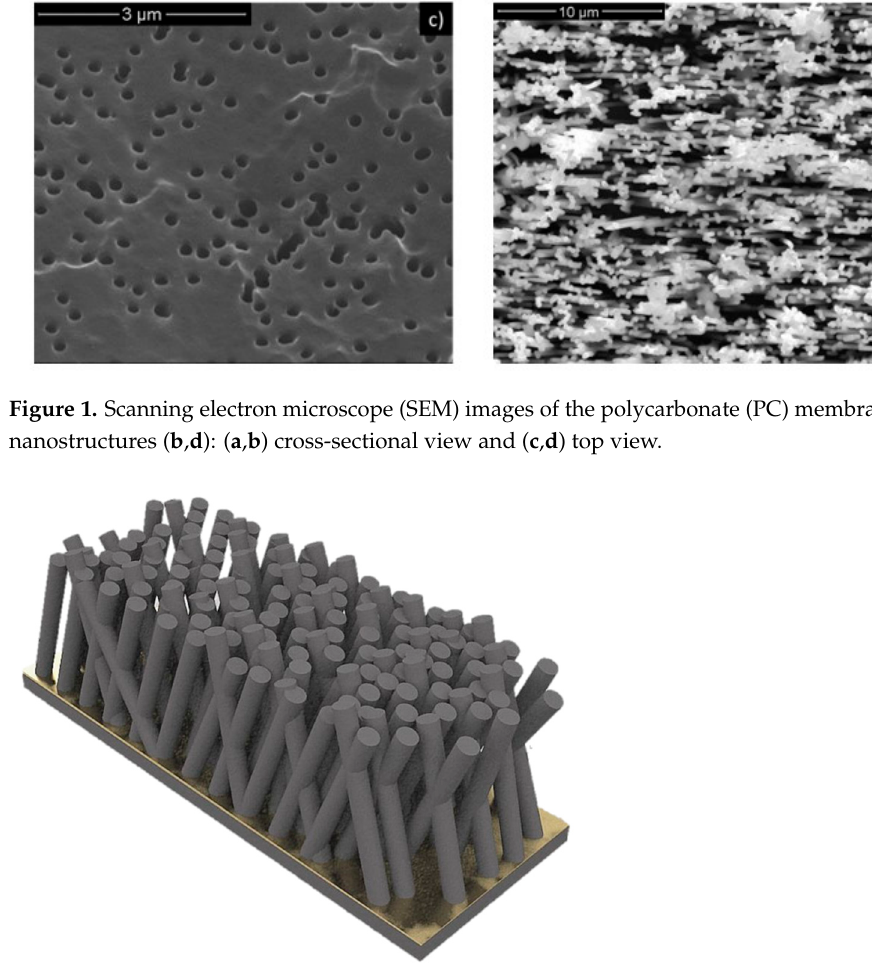
Figure 2. Scheme of the nanostructured